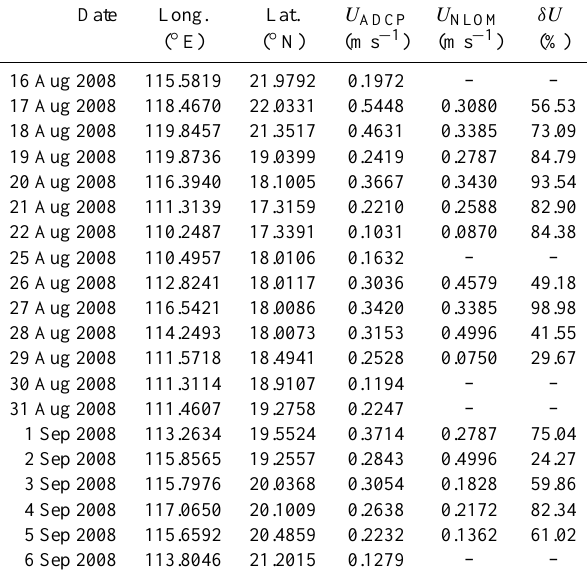
Table 1. Comparison of current speed derived from NLOM with cruise